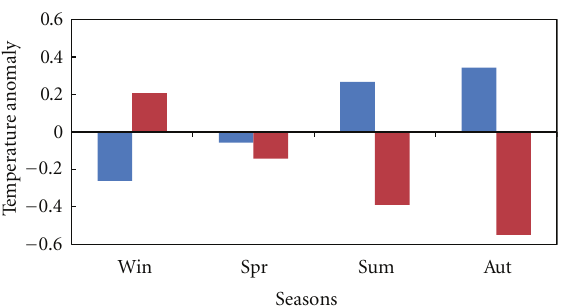
Figure 3: Composite seasonal mean Nino-3 SST anomaly during positive (blue column) and negative (red column) phases of ESI